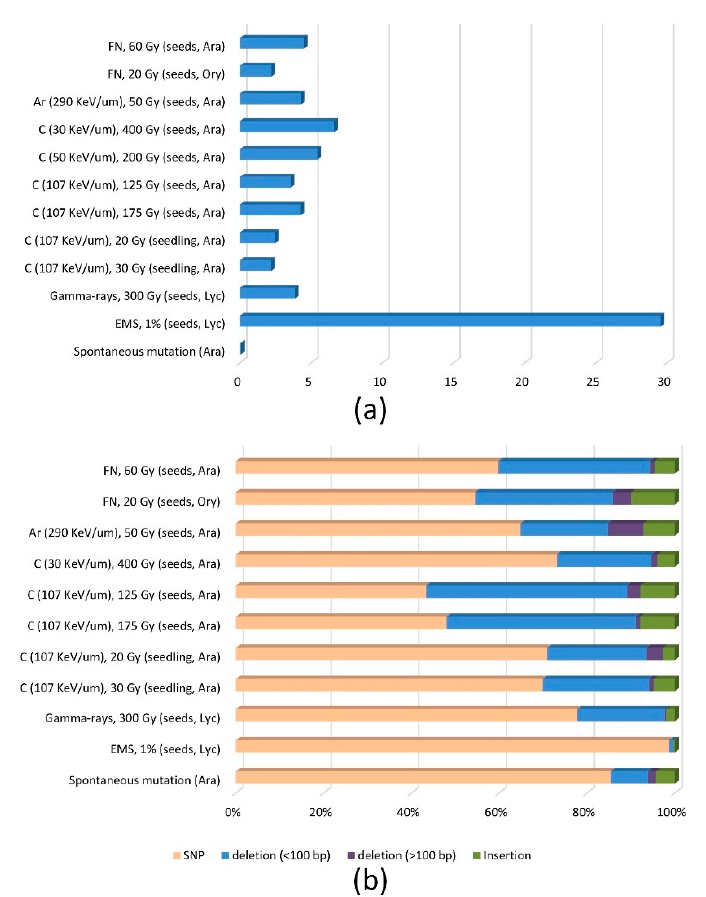
Figure 2. Frequency and spectrum of DNA mutations in mutant lines derived by irradiation. ( a ) Mutation frequency ( × 10 − 7 / bp) estimated for the M 1 generation. ( b ) Proportion of single base substitutions (SBSs) and InDels. ( c ) Spectrum of SBSs. The genome information from the studies listed in Table 1 was analyzed. For fast-neutron-irradiated rice, the genome information from Li et al. (2017) [27] was used, but that from Li et al. (2016) [25] was not because the materials in Li et al. (2016) [25] were included in Li et al. (2017) [27]. The results of Du et al (2017) [24] were omitted from ( b ) because large InDels were not analyzed. Regarding the argon beam irradiation (290 KeV µ m − 1 ), the genome information from Kazama et al. (2017) was used, but that from Hirano et al. (2015) [11] was not because Kazama et al. (2017) [12] analyzed more samples; the irradiation conditions were identical in both studies.